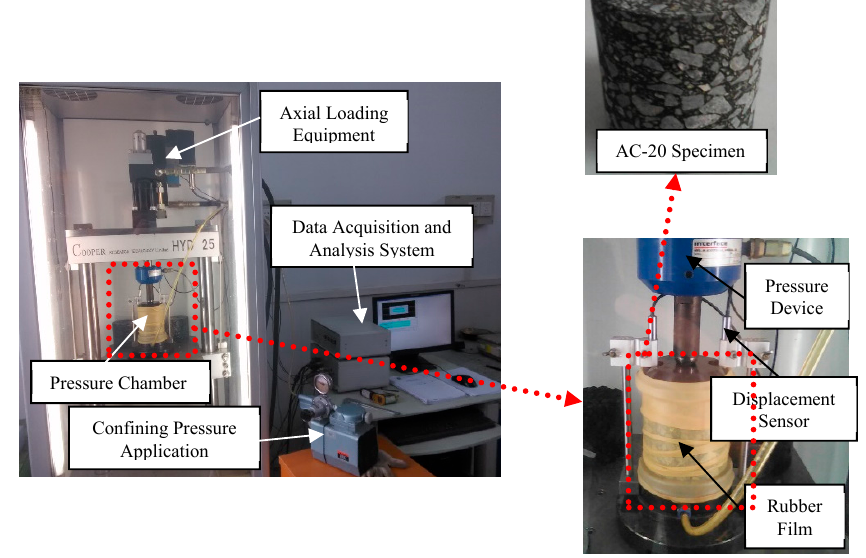
Figure 4. The basic composition of the HYD-25 triaxis instrument.